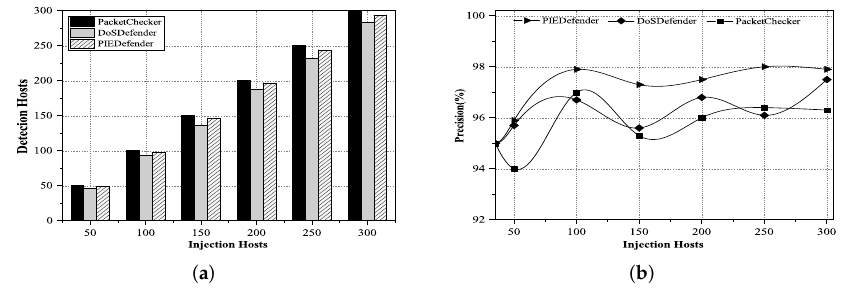
Figure 8. Comparison of injection detection. ( a ) Detection hosts. ( b ) Detection